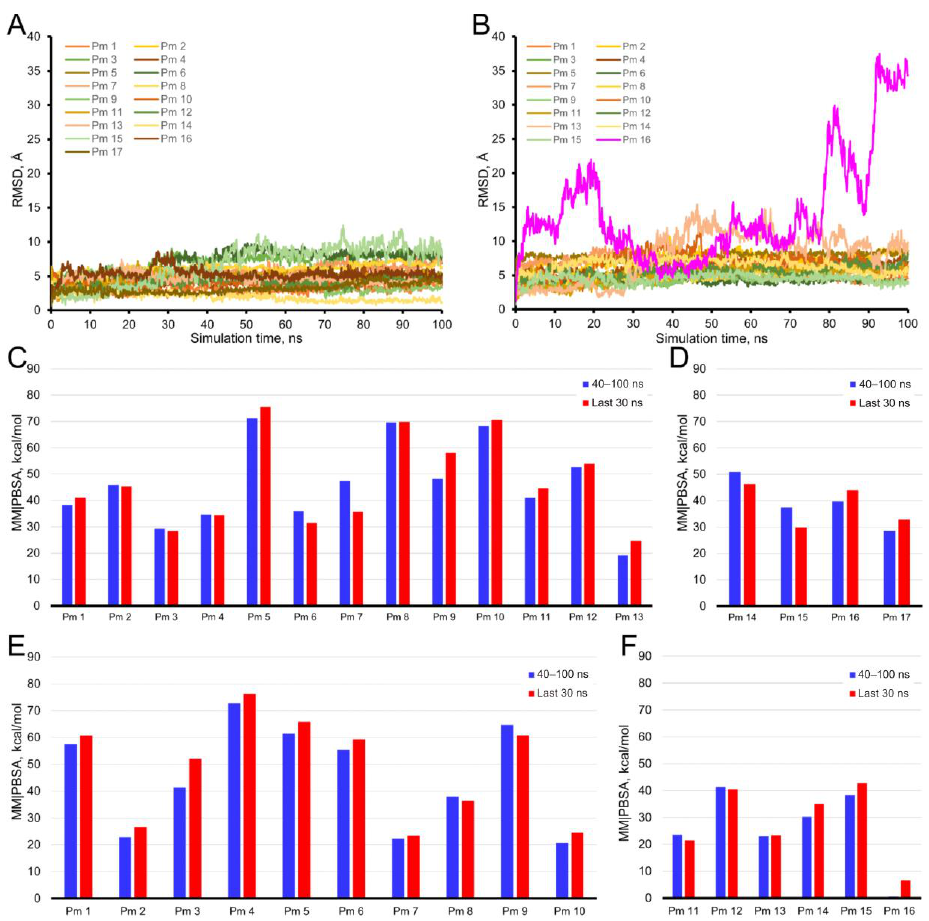
Fig.10 Figure 10. Analysis of MD simulations for Pm bound to the ECD and TMD of nAChR in open and closed conformations. Panels ( A ) (open conformation) and ( B ) (closed conformation) display the trajectory through a 100 ns simulation of a Pm molecule sited in each main cluster at the TMD and the ECD, as numbered in Figure 9A,B. Panels ( C ) (TMD, open), ( D ) (ECD, open), ( E ) (TMD, closed), and ( F ) (ECD, closed) display the free energy analysis (MM|PBSA) of the Pm-nAChR complexes at two MD trajectory intervals (40 to 100 ns and the last 30 ns). YASARA-calculated binding energy provides positive values when the predicted binding is strong and stable, whereas negative values indicate unstable or no